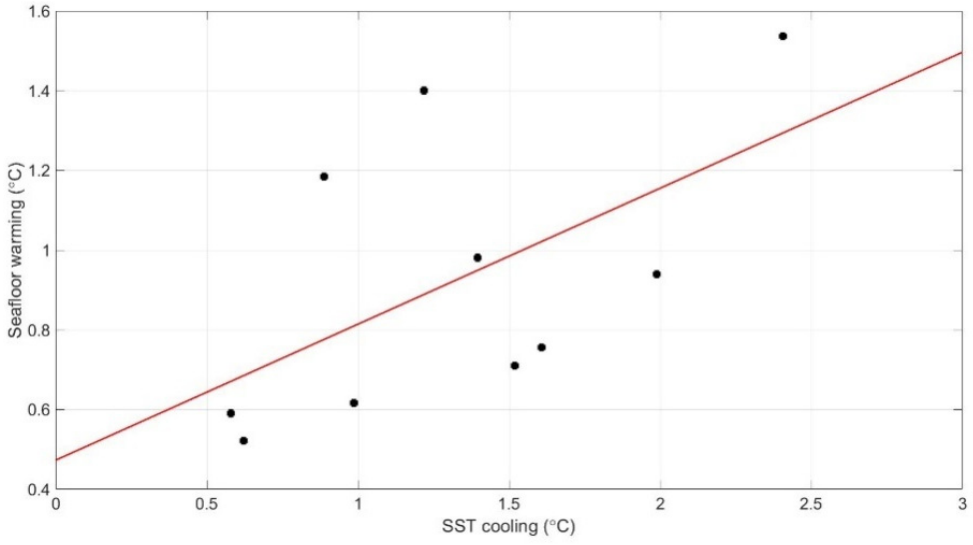
Figure 10. Scatter plots of the seafloor warming versus SST cooling. Note that the results corre- sponding to typhoons Tembin and Bolaven are not shown. The red line denotes the linear fitting result.